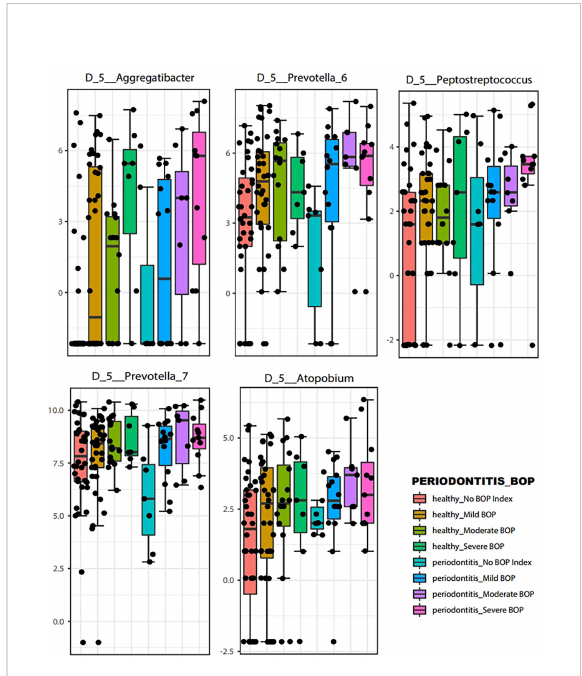
FIGURE 6 Boxplots of representative bacteria identi fi ed by LEfSe to display the microbial differences according to Bleeding on Probing severity at the genus level (p <